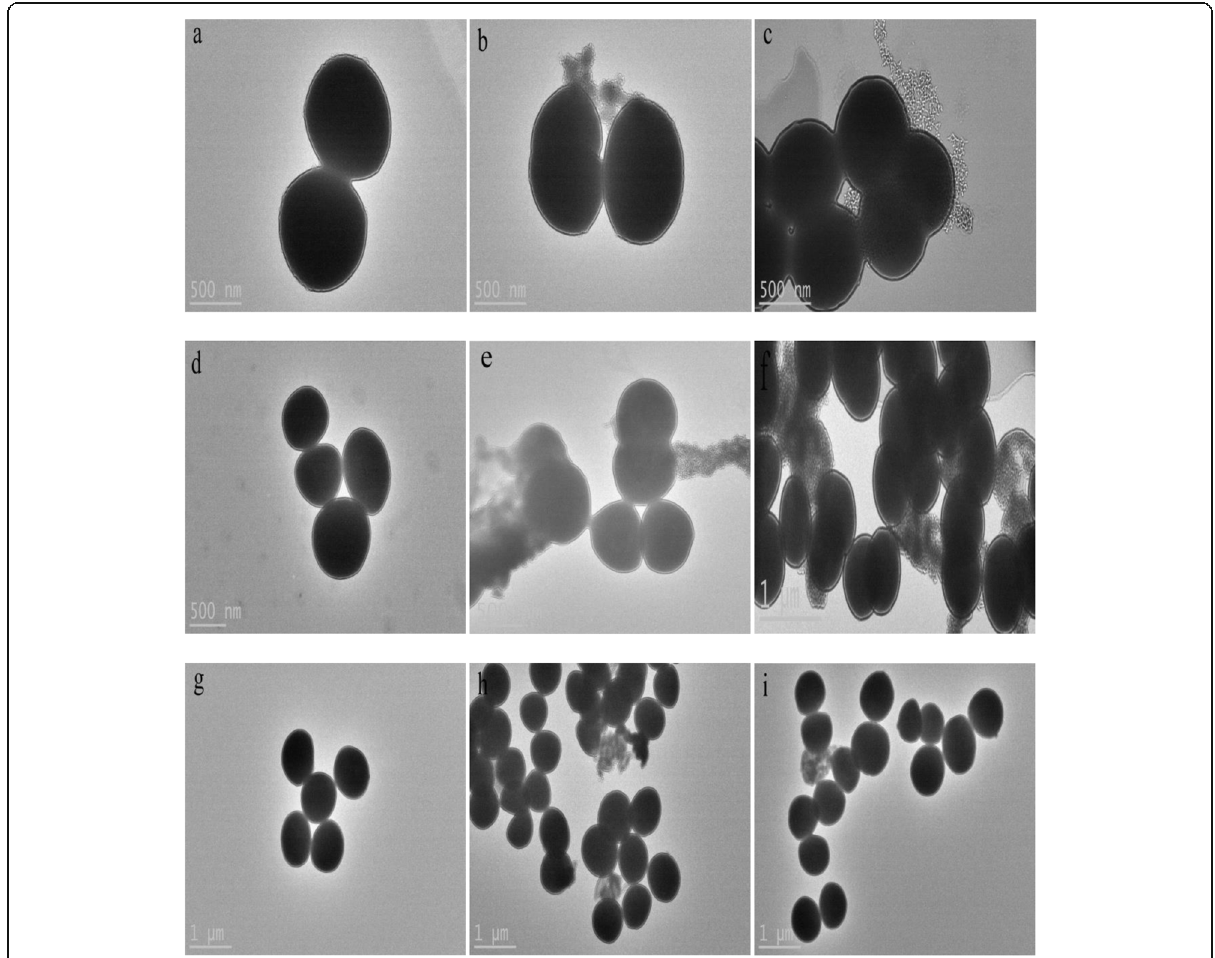
Fig. 6 TEM images of SA ( a , b and c ), MRSA ( d , e and f ) and ESBLs-SA ( g , h and i ) treated by chelerythrine for 1.5 h ( b , e and h ), 6 h ( c , f and i ); and control ( a , d and g